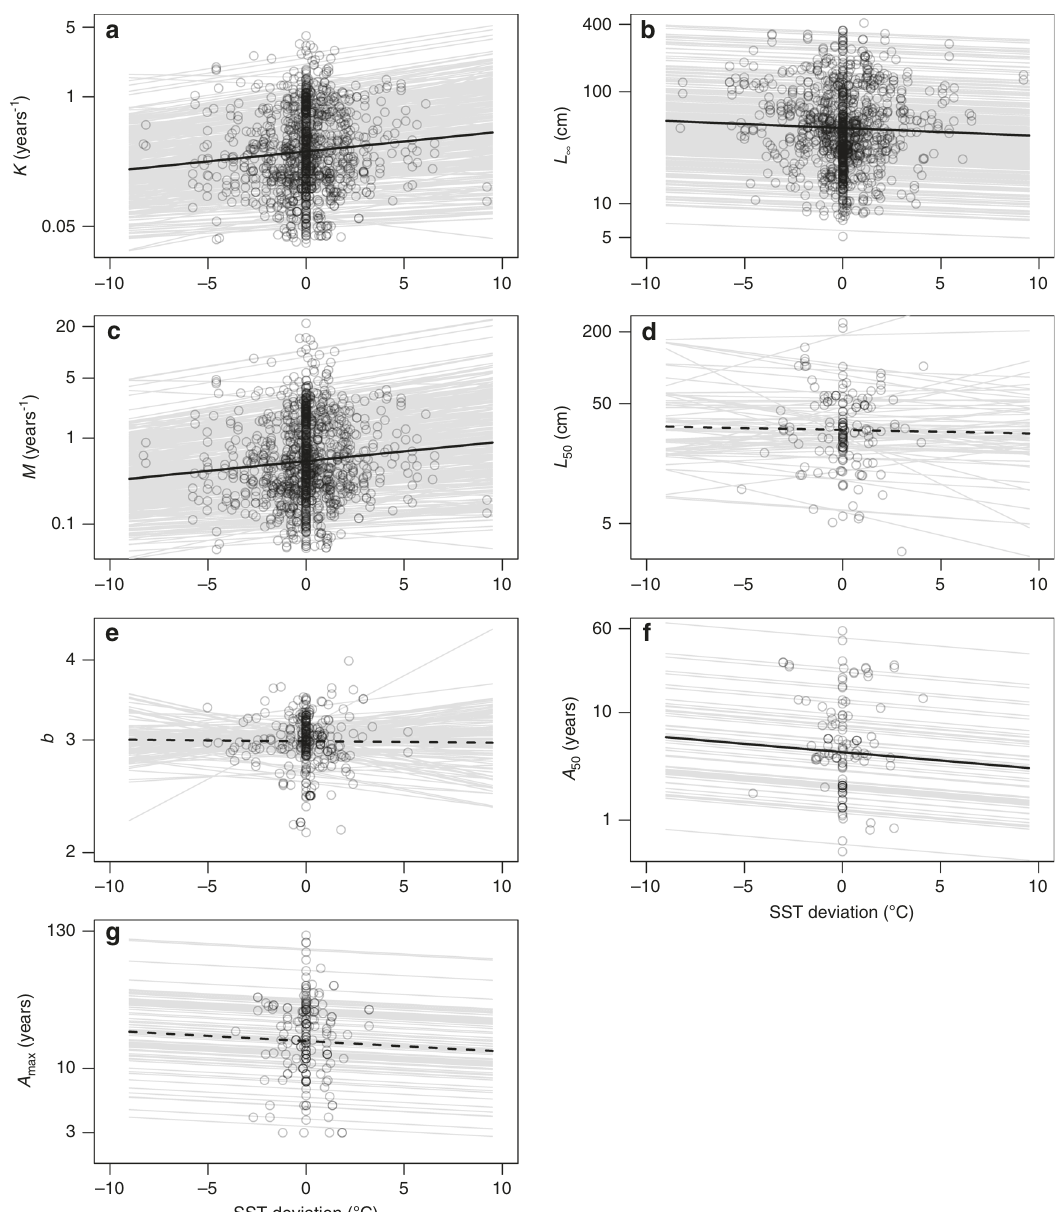
Fig. 2 Temperature effects on life-history traits for the Indo-Paci fi c fi shes. The bivariate relationships between temperature deviation (deviation from the species-speci fi c mean sea surface temperature, SST) and each life-history trait are examined using linear mixed-effect models ( K , L ∞ , M (at A 50 ), L 50 , b , A A – g ). Thick black lines represent the tendency lines of the fi xed effect of SST deviation (solid and dashed lines, respectively, correspond to 50 , and max , a signi fi cant and non-signi fi cant fi xed effects), and thin gray lines are the tendency lines for individual species. The vertical lines of data points at mean temperature (anomaly ~0 °C) re fl ect either a large number of single-population species or reef fi shes with narrow ranges of habitat temperatures in our